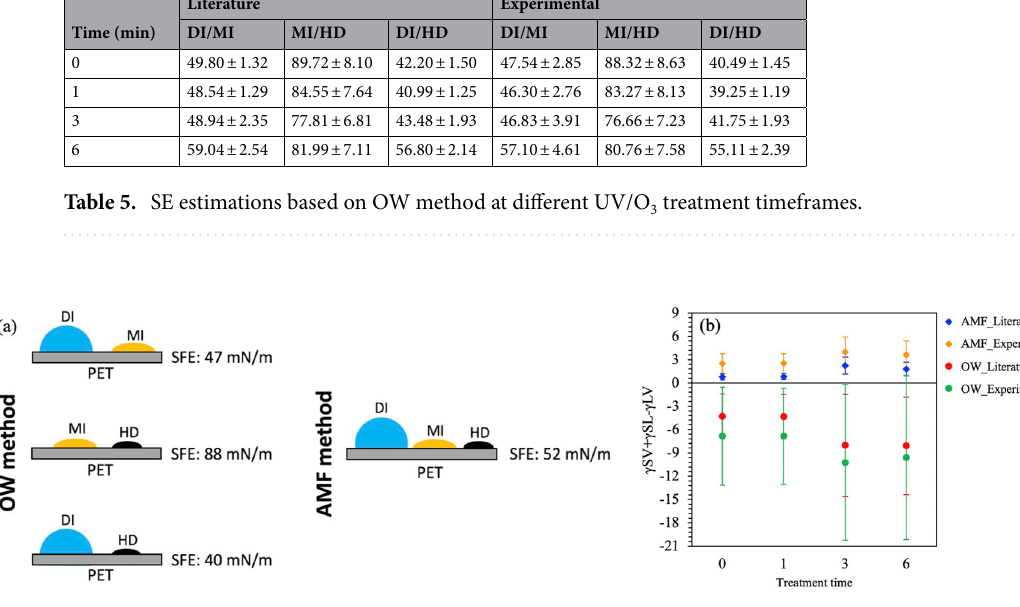
Figure 3. ( a ) The effect of test liquids on the SE analysis based on the OW and AMF methods, ( b ) Uncertainty of OW and AMF satisfaction of Antonow’s